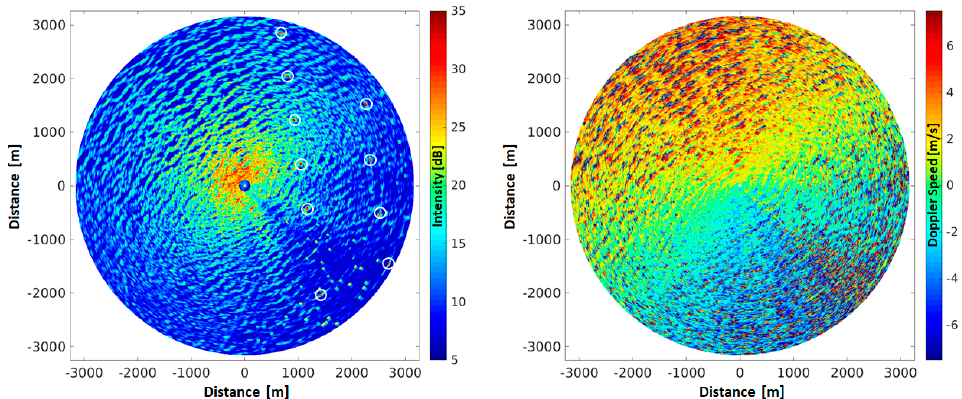
Figure 7. Radar intensity ( left ) and Doppler speed ( right ) image resulting from one single antenna rotation (at 0.6 Hz) from the MR operated at the Research Platform FINO-3, located in the German Bight of the North Sea. The data were collected on 29 October 2017 at 11:54 UTC utilizing horizontal (HH) polarization.